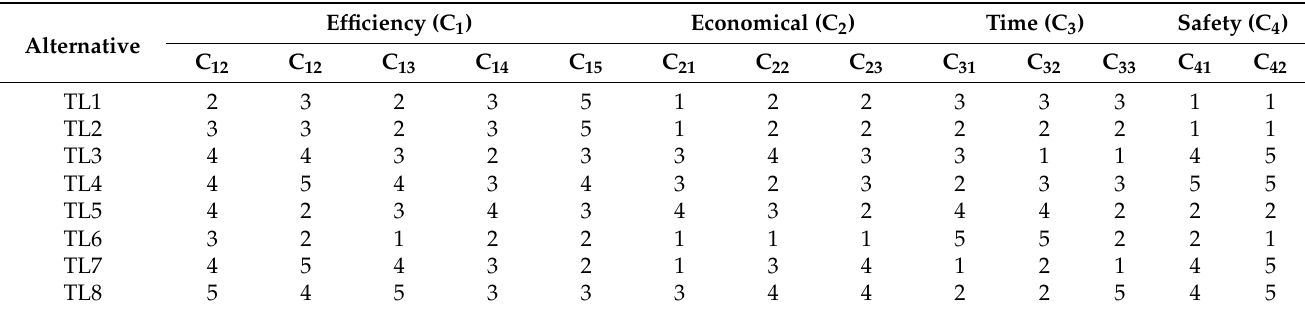
Table 4. Evaluation rank value for all the business process modelling tool selection sub-criterions in Table 1.